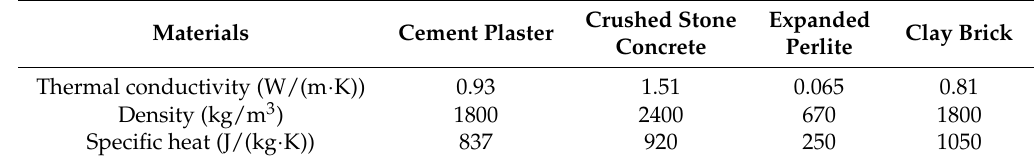
Table 2. Physical properties of the wall materials.